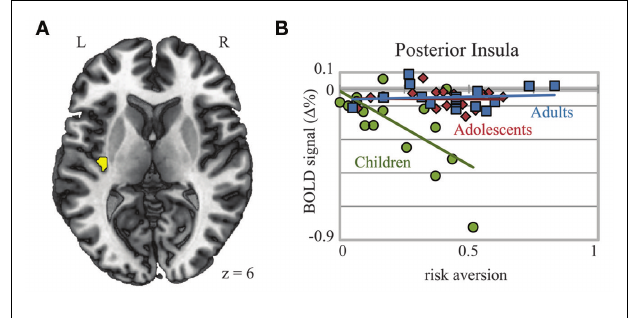
FIGUREA1 | Posterior insula shows age group by risk aversion interaction. (A) An interaction between age group and risk aversion in posterior insula showed that (B) while activation during decision-making in adolescents and adults did not correlate in any way with risk aversion, activation in children decreased with greater risk aversion, in children, activation in posterior insula decreased with greater risk aversion. Coordinates in MNI space.